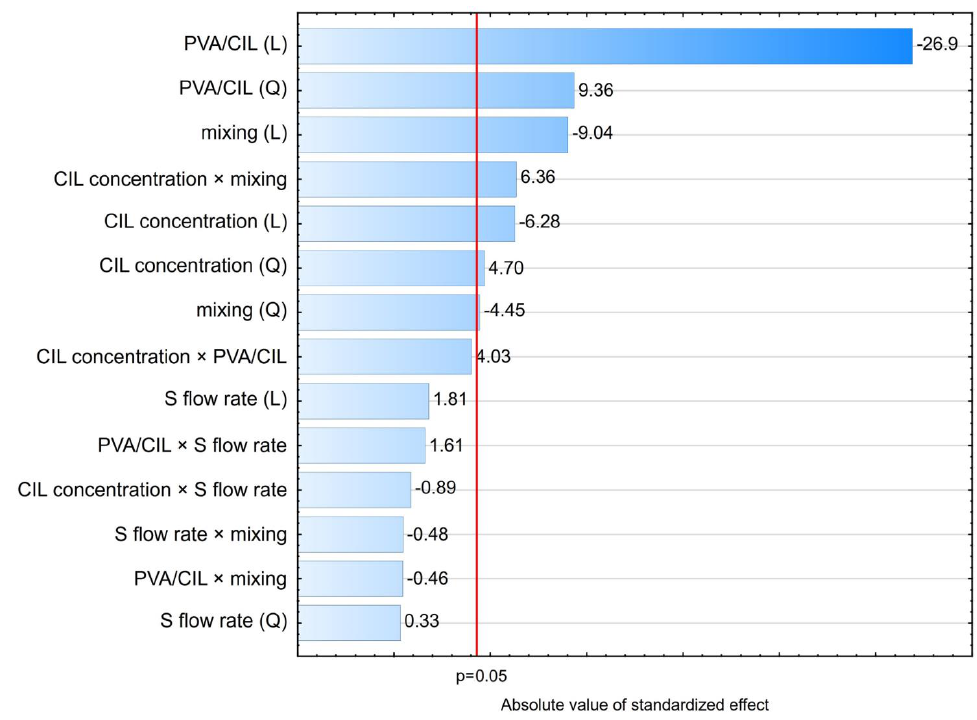
Figure 3. Pareto chart of the standardized linear (L), quadratic (Q) and linear interactions effect sizes of independent variables in liquid antisolvent precipitation (LASP) process studied according to central composite design plan. Bars above the red line denote statistically significant effects at p <